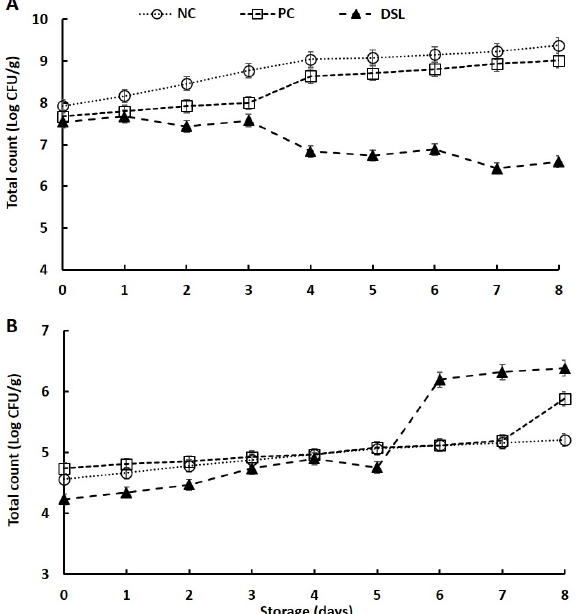
Figure 4. Changes in total bacterial ( A ) and total yeast ( B ) counts of date syrup-fortified laban (DSL), positive control (PC), and negative control (NC) drinks during cold storage at 4 °C for 7 days. 3.7. Sensory Evaluation of Date Syrup-Fortified Laban Drink (DSL) during Cold Storage Sensory evaluation was conducted for DSL drink at day 0 and day 7 of storage in comparison with that negative control (NC) at the seventh day of storage. Fresh DSL drink showed the highest scores on all sensory attributes (Figure 5). At the end of the storage period (7 days), DSL drink exhibited higher scores ( p < 0.05) on all sensory attributes than the NC drink, indicating that incorporation of date syrup in laban beverage enhanced the sensory quality of the product. In addition, date syrup also preserved ( p < 0.05) the sensory attributes of laban drink after 7 days of storage. The enhancement of sensory attributes of DSL drink is likely due to the sweet taste and flavor of date syrup, whereas the improvement in the storage stability of the DSL drink could be due to the high sugar content of date syrup, which reduced the water activity of the developed product and thereby eliminated the growth of spoilage microbes. In agreement with these findings, fortification of fermented dairy products with dates significantly improved their sensory attributes compared with non-fortified samples [34,35,49,50,67]. Overall, the findings of this study indicate that fortification of laban with date syrup enhanced the sensory acceptability of this product and hence can promote the large-scale production, trading, and consumption of this dairy beverage.